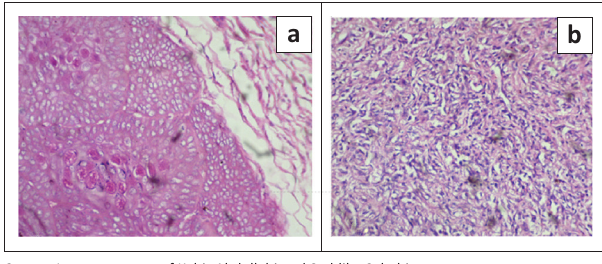
FIGURE 4: (a) Section showing a lobular lesion composed of enlarged keratinocytes with central eosinophilic molluscum bodies. (b) Section showing plump spindle cells with bland nuclei delimiting slit-like vascular spaces, consistent with Kaposi sarcoma. Haematoxylin and eosin staining X 200.